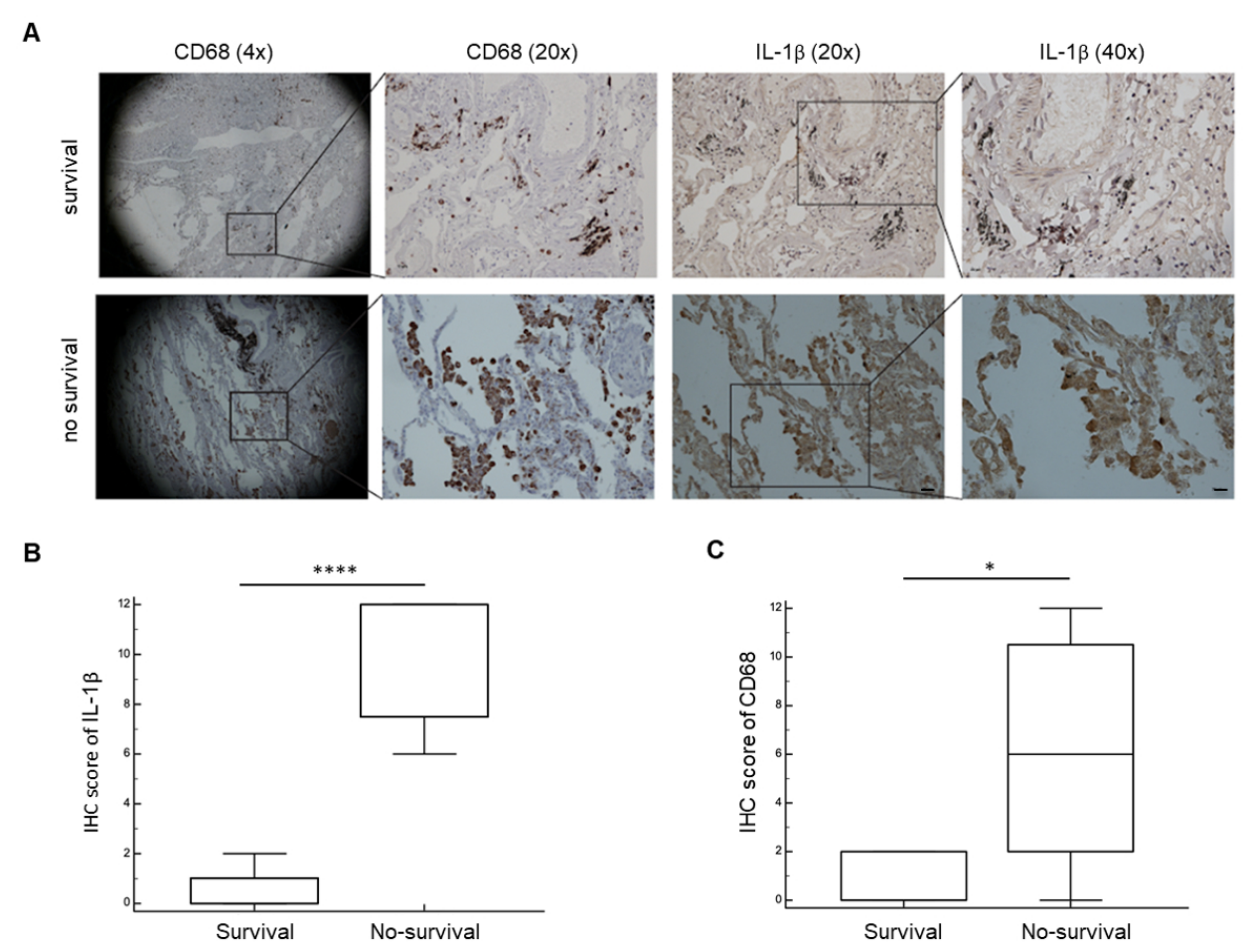
Figure 3. Biological analysis of tumor microenvironment in lung tissue. ( A ) Representative im- munohistochemical images for CD68 (macrophages) and IL-1 β expression in lung tumor tissue and adjacent normal tissues. The boxed areas are enlarged to show staining for CD68 and IL-1 β . Magnification 4 × , 20 × , and 40 × ; ( B ) analysis of IHC scores of IL-1 β expression in lung tumor tissues and adjacent normal tissues ( n = 14); ( C ) analysis of IHC scores of CD68 expression in lung tumor tissues and adjacent normal tissues ( n = 14). p –values were determined by an unpaired t -test. Bars: S.E.M. * p < 0.05; **** p <